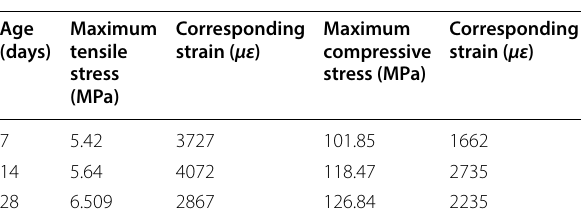
Table 7 Tensile and compressive stress–strain values with modulus of elasticity for UHPFRC (T3) at different ages UHPFRC with micro and hooked ends steel fibers